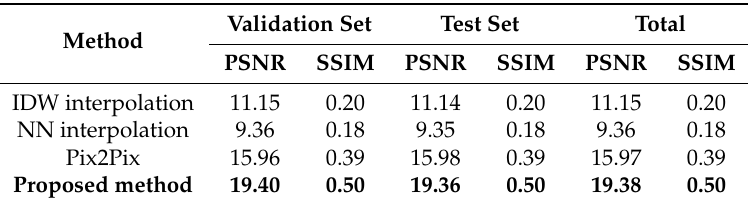
Table 6. Performance results of the proposed method and conventional methods. Bold-faced numbers indicate the top-ranked method and its